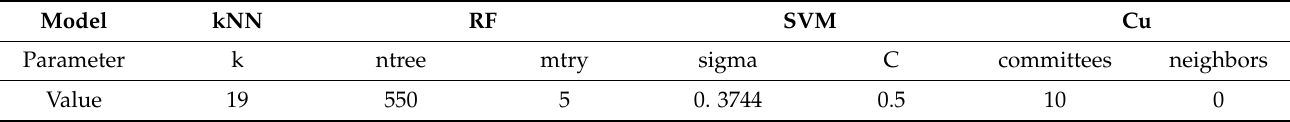
Table 3. The best model parameters for predicting CEC in the study area.